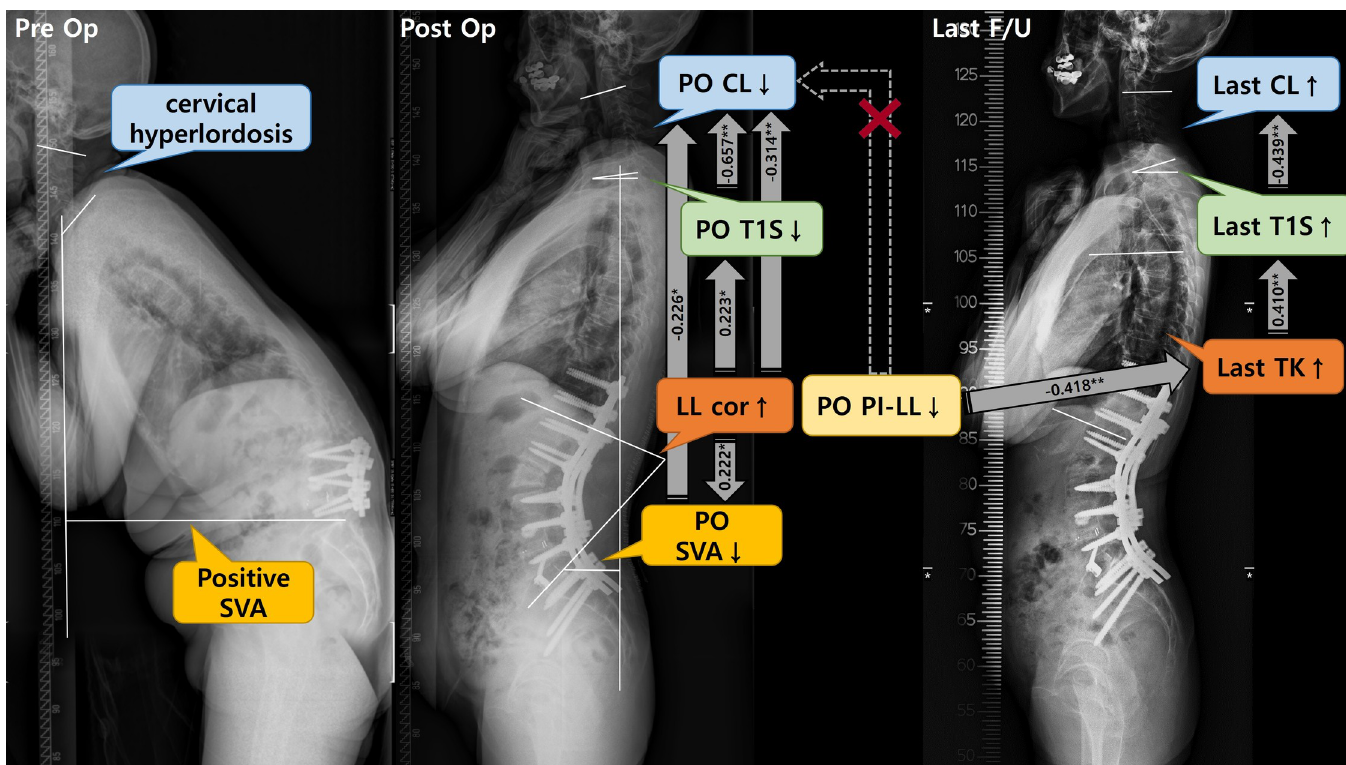
Fig 3. Case. A 62-year-old female with degenerative sagittal imbalance and cervical hyperlordosis (C7SVA + 293mm, TK -4˚, LL 21˚, PT 29˚, PI 51˚, CL -30˚, T1S 45˚) underwent PSO on L2, PLIF on L4-5, ALIF on L5-S1, and posterior spinal fusion from T10 to S1 with sacropelvic fixation and accessory rod fixation. Optimal sagittal alignment was obtained after correction (C7SVA -48mm, TK 12˚, LL -65˚, PT 5˚), but cervical kyphosis occurred (CL +16˚, T1S 10˚). A relatively large amount of LL correction due to the high PI led to a drastic reduction in Post C7SVA and subsequent reduction of Post T1S and CL. Radiograph at 2 years postoperatively showed a well- maintained optimal sagittal alignment with restoration of cervical lordosis (C7SVA -24mm, TK 27˚, LL -66˚, PT 5˚, CL -5˚, T1S 15˚). TK increased to achieve spinopelvic harmony resulting from the postoperative difference in LL relative to PI. This modification in TK led to gradual optimal changes in T1S and CL over